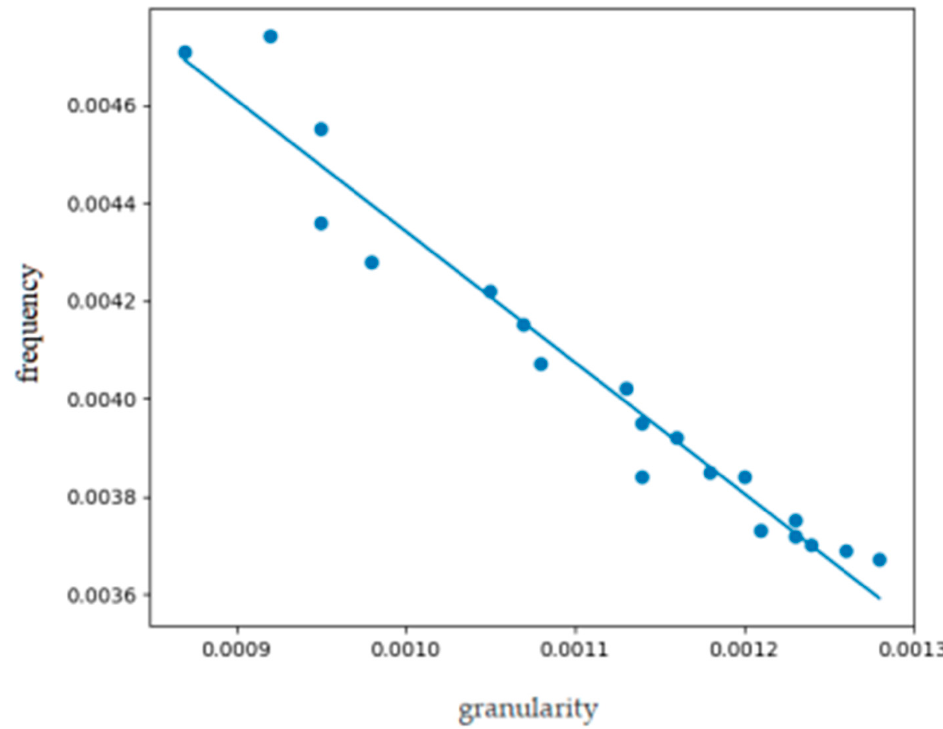
Figure 6. Linear regression model of ore granularity and motor frequency.